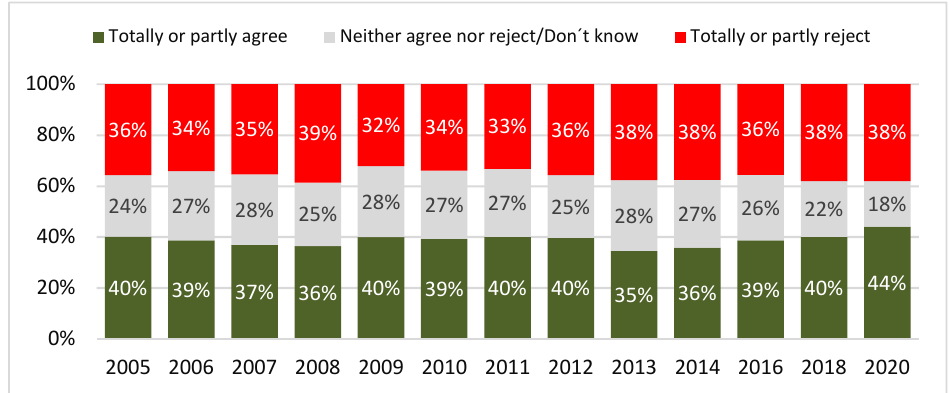
Figure 11. Negative statement about exploitation of social benefits: many people with foreign background come to Sweden to exploit the Swedish social welfare benefits.